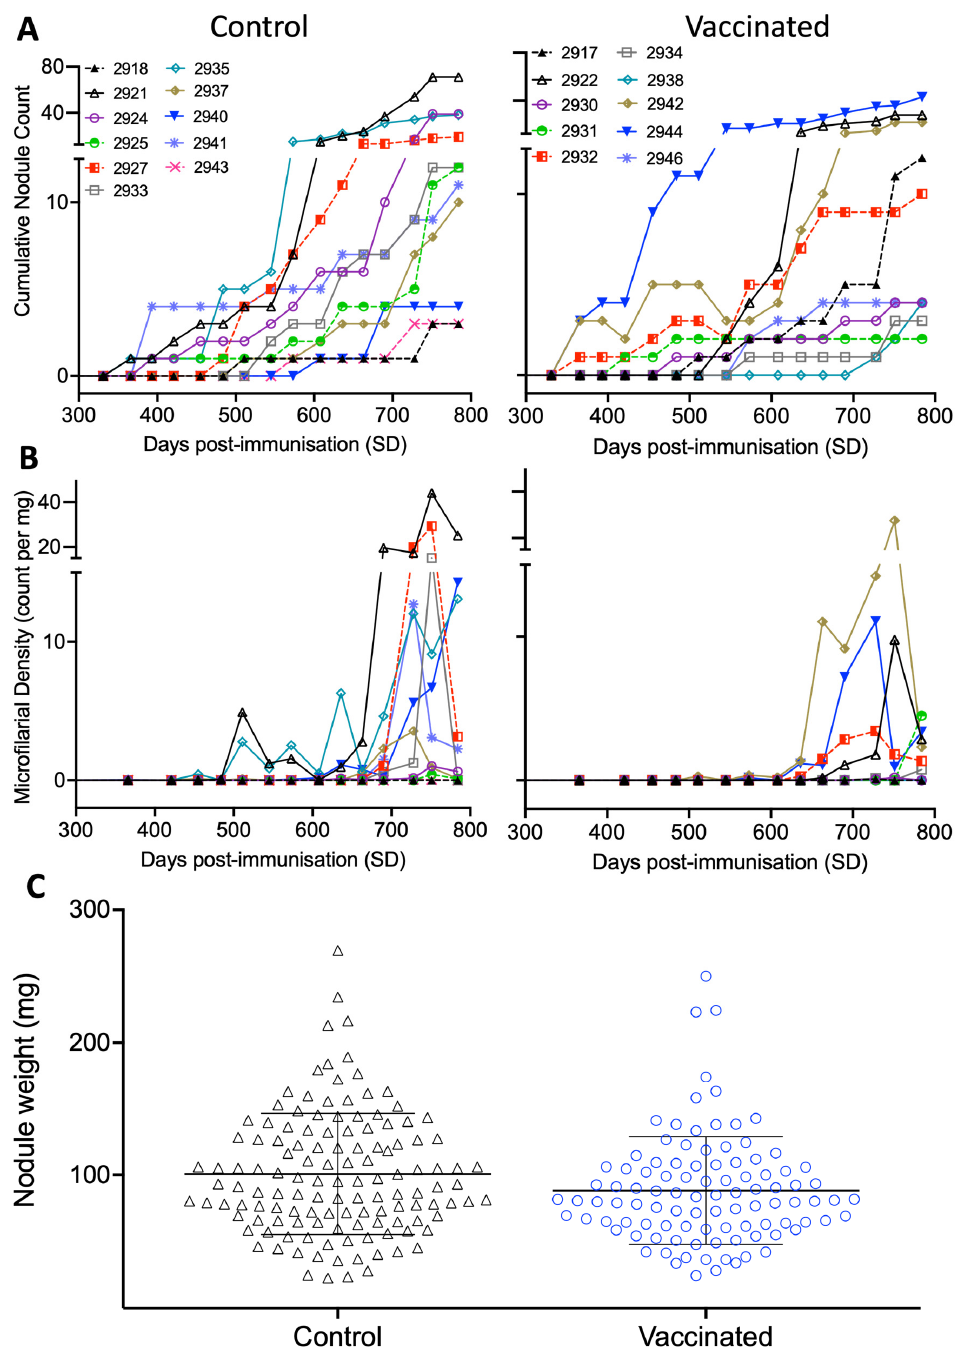
Figure 3. Parasitological burdens and in infection kinetics in main study animals resulting following natural exposure to O. ochengi (SD100). ( A ) Female worm burdens identified by manual palpation and confirmed at end-point sampling and ( B ) Onchocerca spp. microfilarial burdens within dermis identified through skin snips. ( C ) Weight of nodules (mg) excised from vaccine efficacy trial animals at endpoint. Bars denote mean with standard deviation. By the final sampling (SD780), mean female worm burdens and microfilarial (Mf) skin densities were 35% and 70% lower in vaccinated versus control animals, respectively. At this time, all calves ( n = 21) had acquired nodules, with microfilaridermia identified in ten of the eleven control group animals, and nine of the ten vaccine group animals.